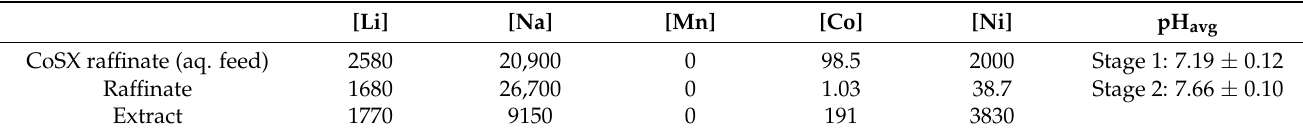
Figure 9. ( a ) A McCabe–Thiele analysis applied on the equilibrium distribution of Ni between 0.8 M D2EHPA (modified by 5 vol-% TBP and diluted in Exxsol D80) and a sulfate solution containing initially 2.41 g L − 1 Li, 2.04 g L − 1 Ni, and 20.8 g L − 1 Na; and ( b ) metal concentrations in the organic phase at different O/A ratios. T = 25 ± 1 °C; pH = 4.7; t eq = 15 min. The operating line was calculated with S/F = 0.3 and 99% Ni removal. Table 4. Compositions of the extract and raffinate in two-stage countercurrent extraction of Ni and Li from the CoSX raffinate by pre-neutralized 0.8 M D2EHPA. S/F = 0.5; T = 21 ± 1 °C; τ mix = 4 min. Concentrations in [mg L − 1 ]. Pre-neutralization: 81.5 mL 10 M NaOH in one liter of 0.8 M D2EHPA (modified by 5 vol-% TBP). Numbering of the stages is started from the organic feed stage.